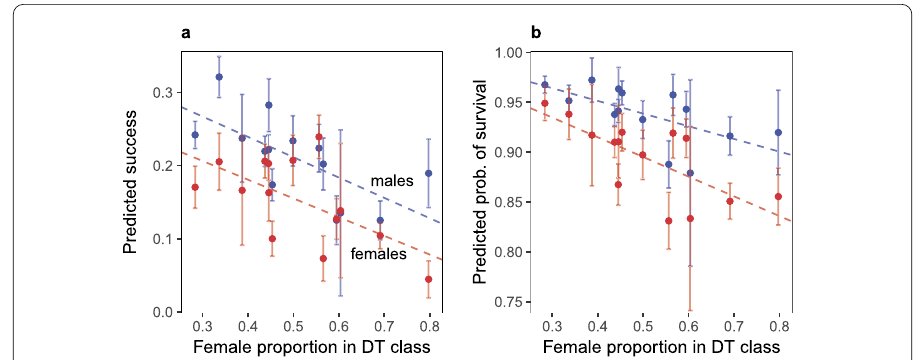
Figure 11 Marginal predictions of success and survival in classes of gendered behavior. Predicted means and 95 percent CI for 14 classes of gendered behavior are marked separately for males (blue) and females (red). Classes are aligned by the female proportion in the decision tree class. Dashed lines show OLS predictions for the predicted class means by the female proportion of the class, separately for males (blue line) and females (red line). Panel ( a ) shows OLS predictions of log( success + 1) as the dependent variable. Panel ( b ) shows predicted probabilities from a logit